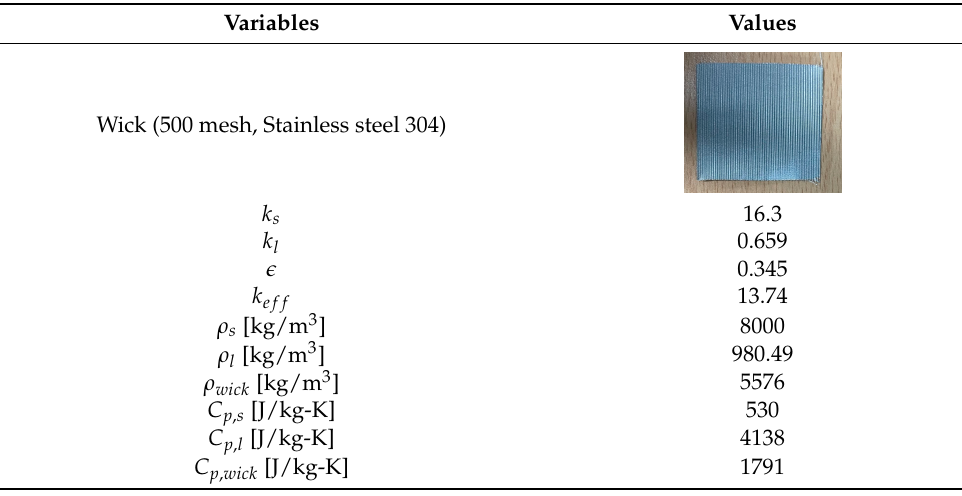
Table 2. Effective thermal conductivity of the wick [4–6,41,42]. Variables